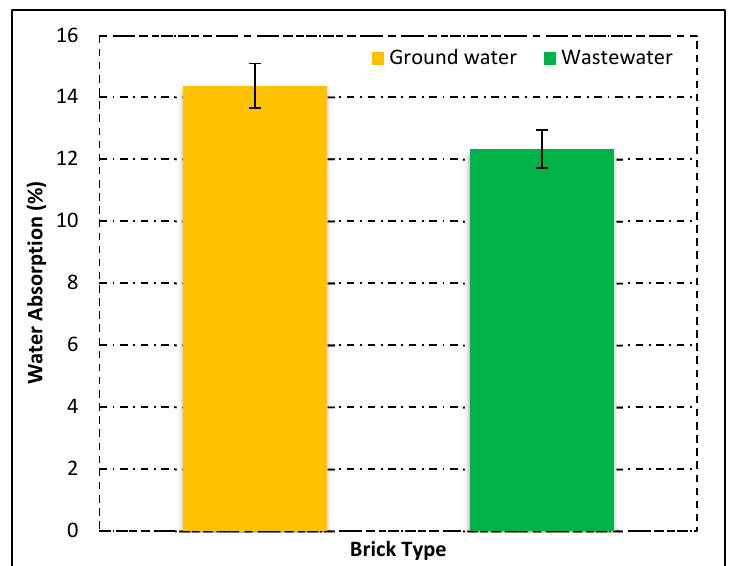
Figure 7. Water absorption of fired clay bricks.